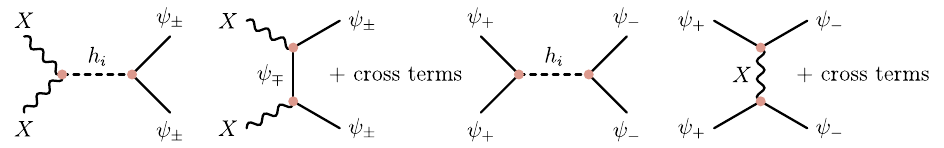
Fig. 4 Semi-annihilation diagrams for the dark particles X ,ψ ± . In these processes two of the dark sector particles annihilate to a dark sector particle and a SM particle in the thermal bath